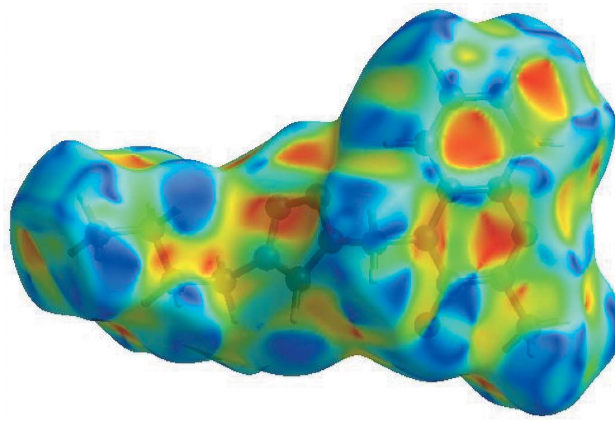
Figure 5 Hirshfeld surface of the title compound plotted over